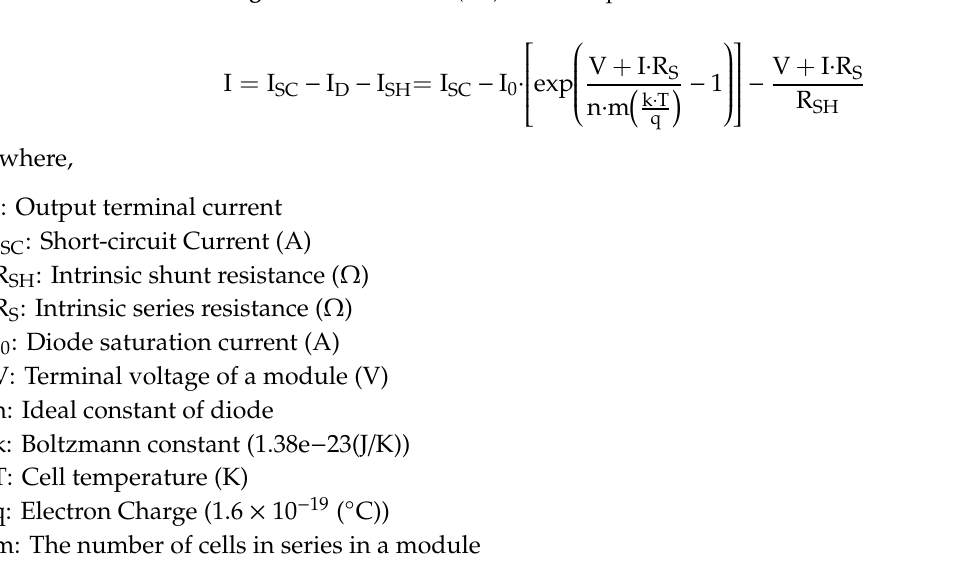
Figure 1. Photovoltaic (PV) module equivalent electrical circuit.